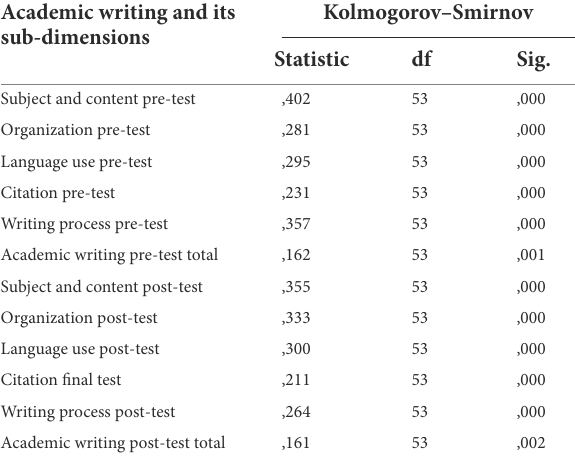
TABLE 4 Normality test results of scores from academic writing and its